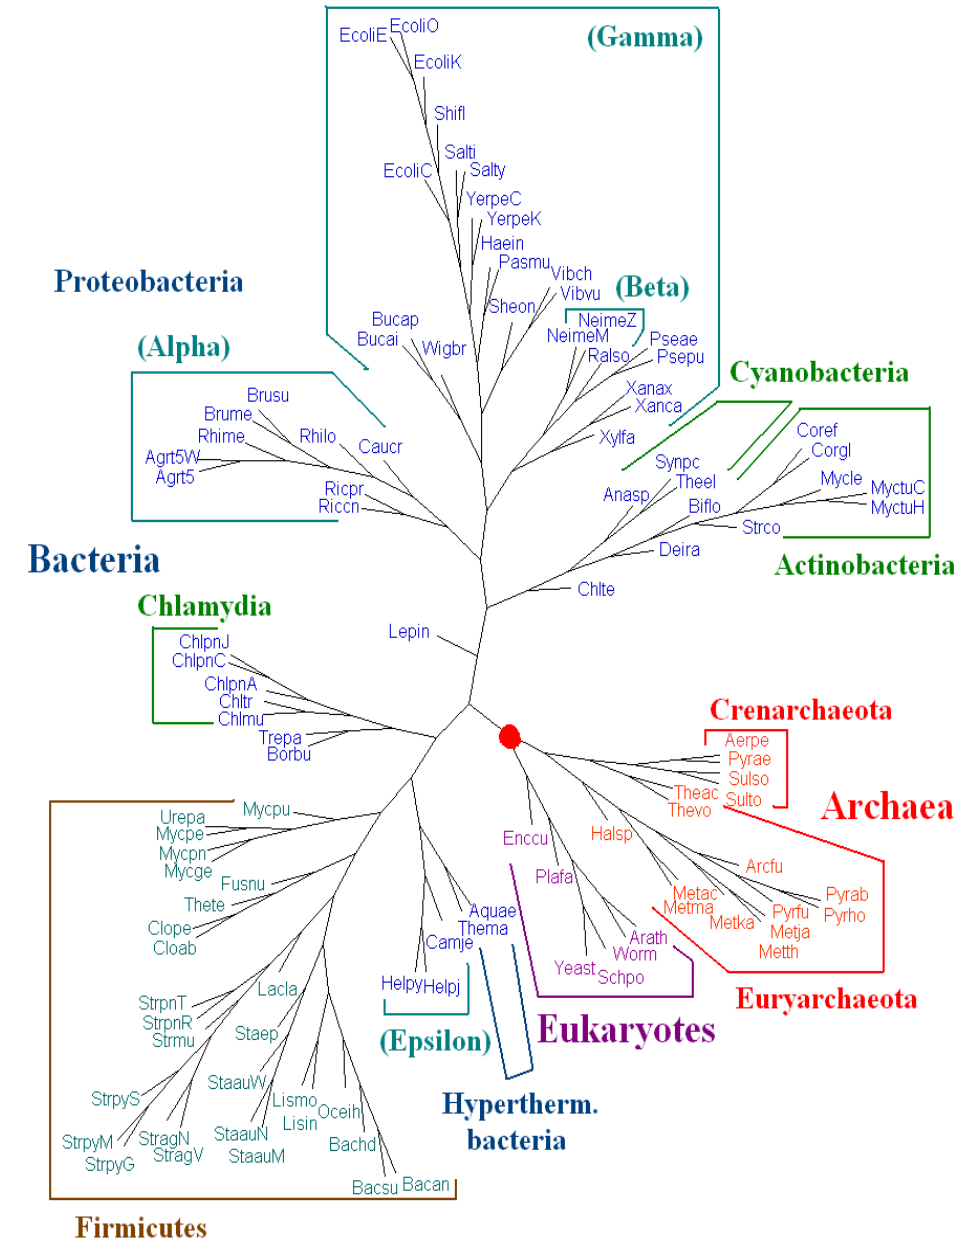
Figure 2. Phylogeny of 109 organisms (prokaryotes and eukaryotes) using the dynamical language approach with chord distance in the case K = 6 based on all protein